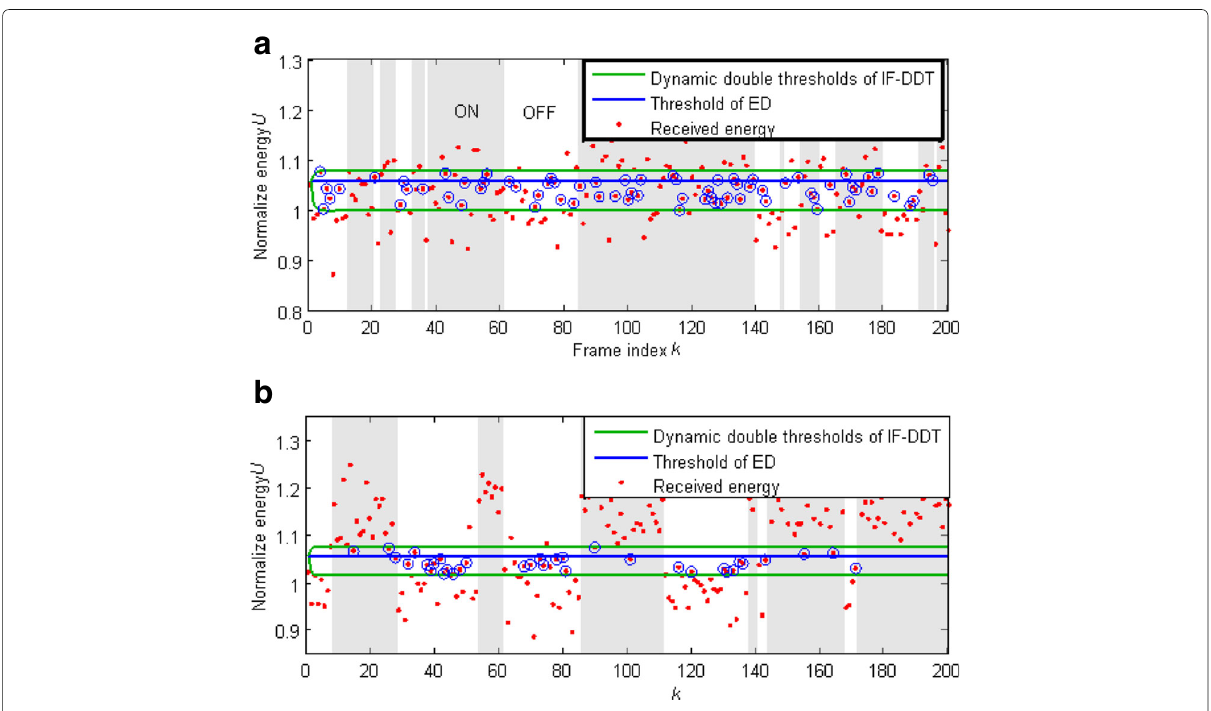
Fig. 4 Thresholds of the IF-DDT sensing scheme. a Thresholds for ¯ T 0 = ¯ T 1 = 200 ms and SNR = − 14 dB. Thresholds of the IF-DDT sensing scheme. b Thresholds for ¯ T 0 = ¯ T 1 = 200 ms and SNR = − 8 dB